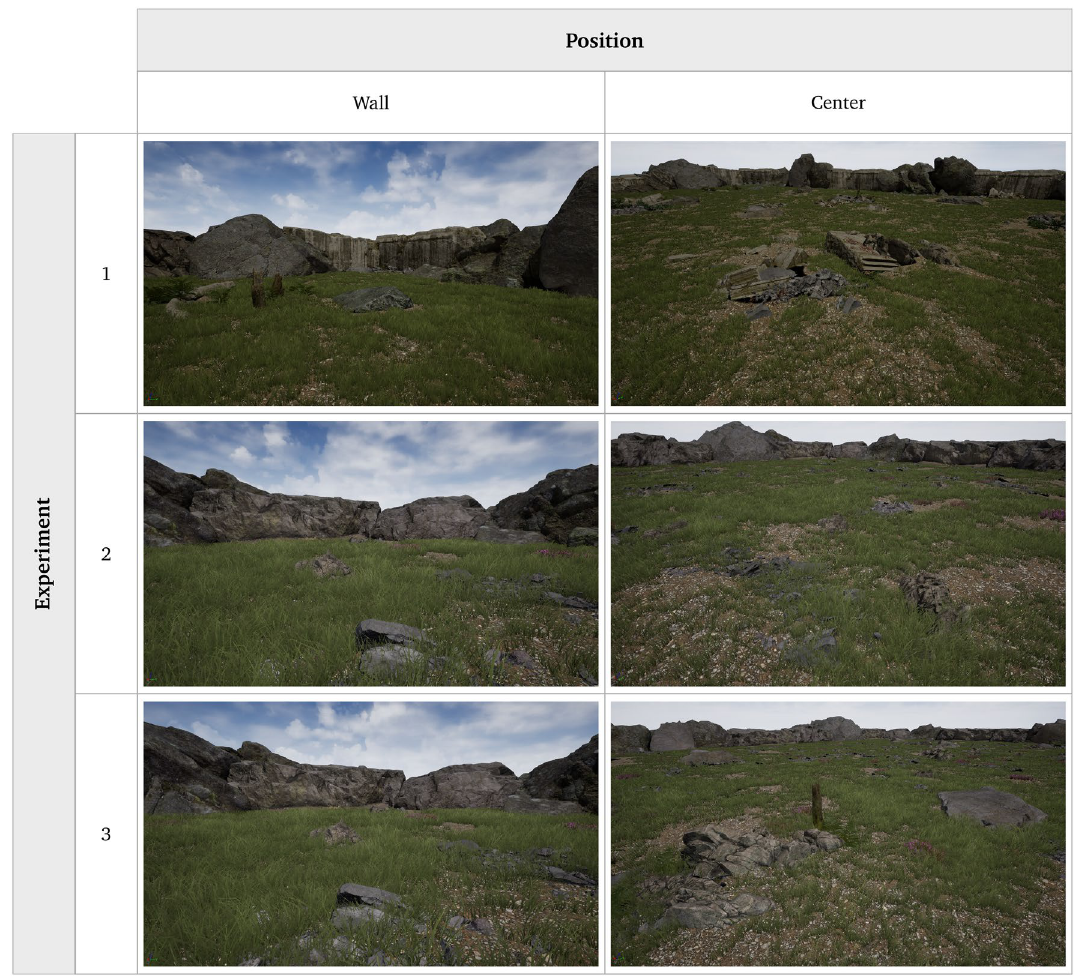
Figure 2. Screenshots depicting the three versions of the virtual human open field